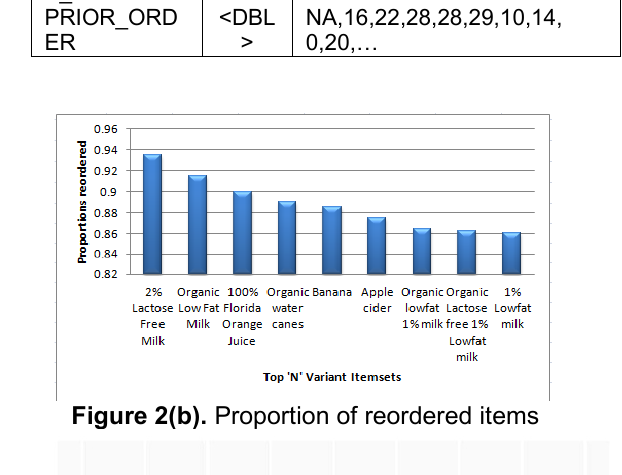
Figure 3(b). Probability reordering unique